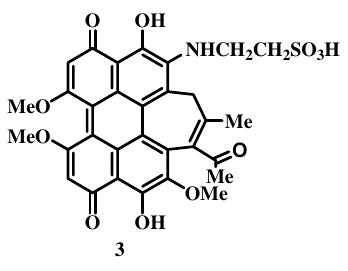
Fig. 3. The molecular structure of compound 3